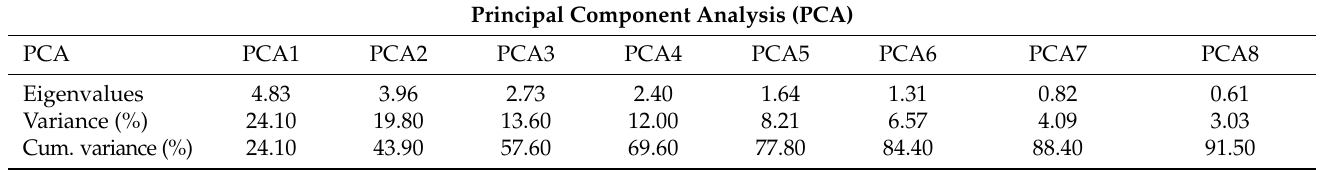
Table 3. Principal component analysis and factor analysis (factorial loadings obtained using the varimax rotation and resulting